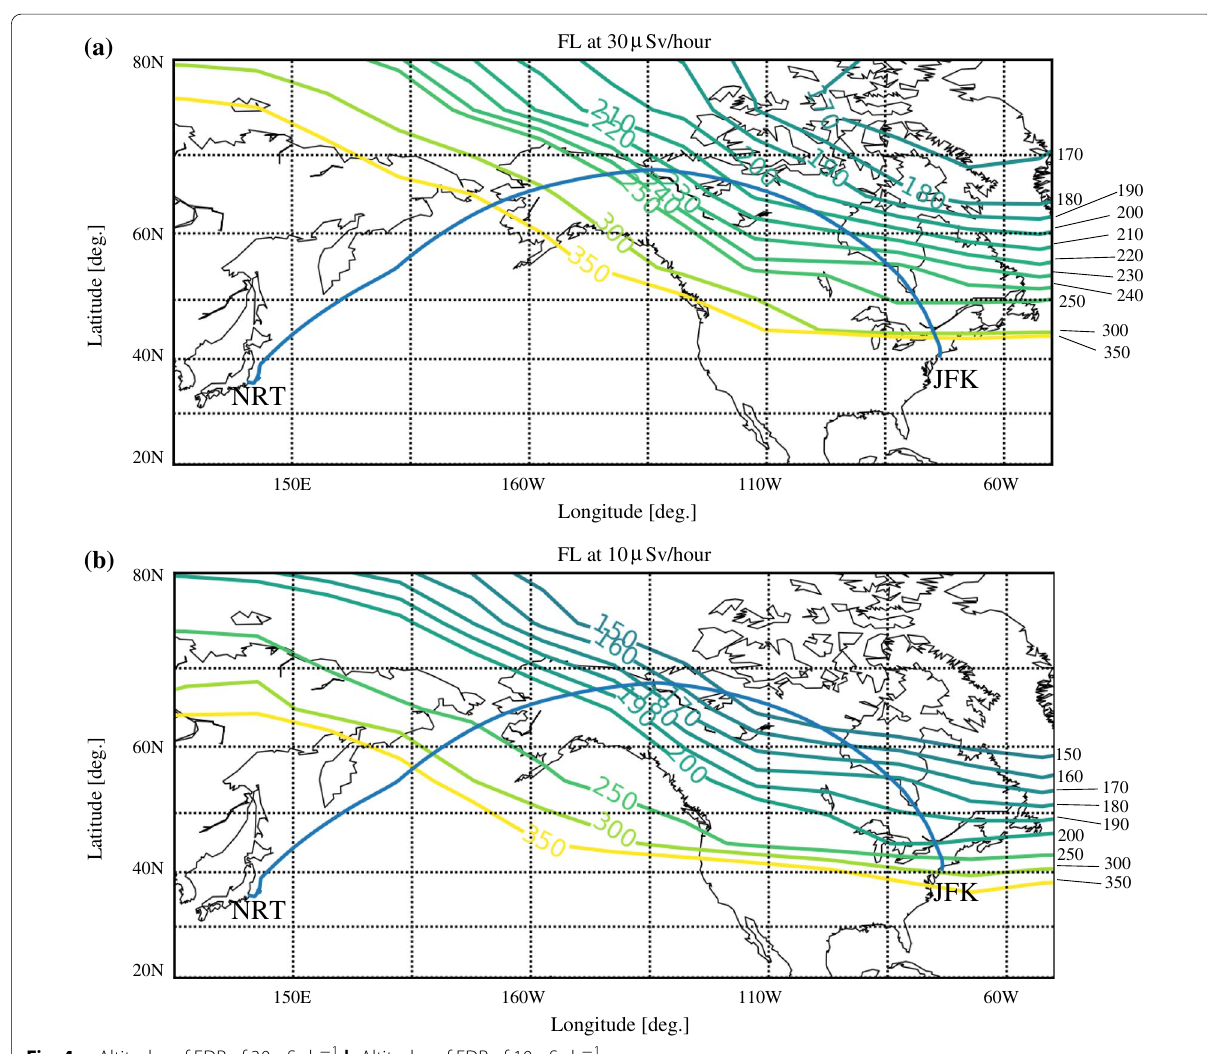
Fig. 4 a Altitudes of EDR of 30 µ Svh − 1 . b Altitudes of EDR of 10 µ Svh − 1